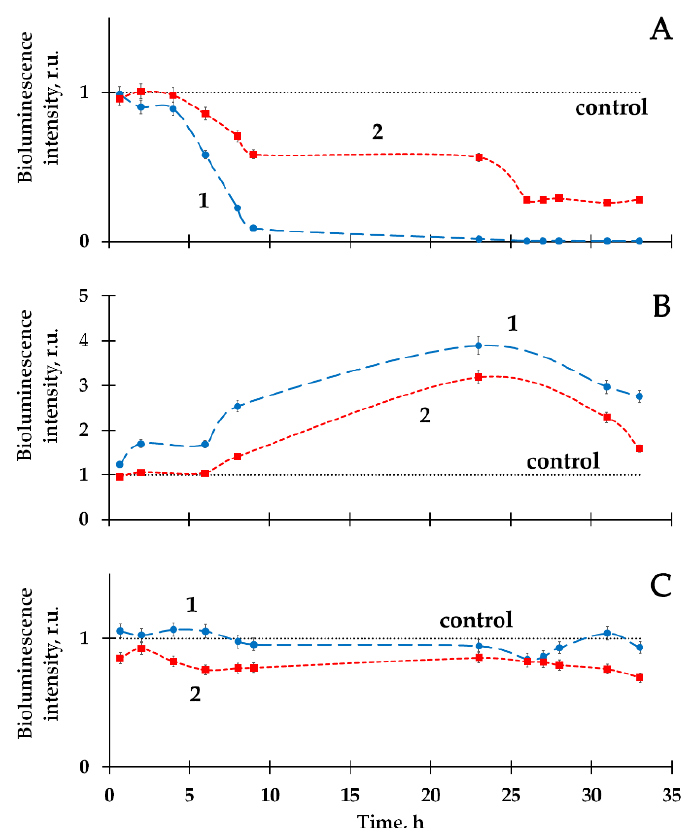
Figure 3. Bacterial bioluminescence kinetics in HTO in the absence (1) and presence (2) of humic substances (HS). Specific radioactivity of HTO: ( A ) 2 MBq/L; ( B ) 50 MBq/L; ( C ) 200 MBq/L. HS concentration—10 − 3 g/L.